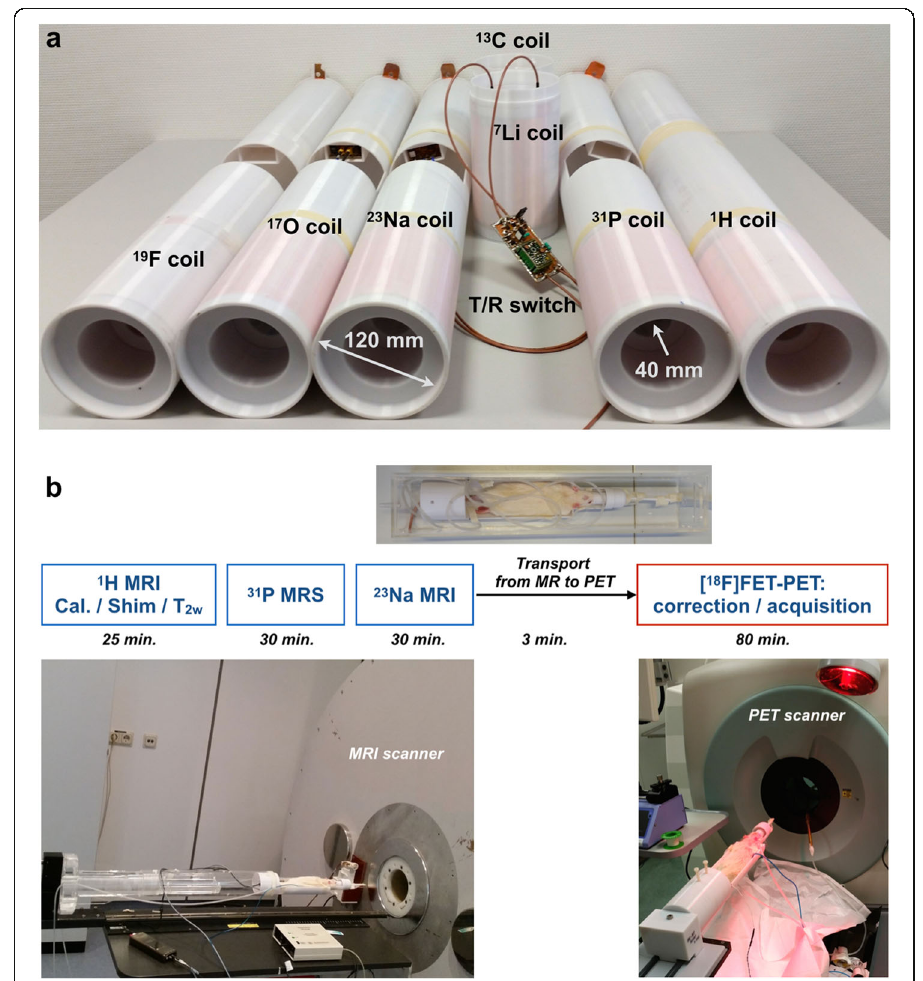
Fig. 1 Picture of multinuclear MRI system showing RF coils and T/R switches ( a ), and MR, PET and